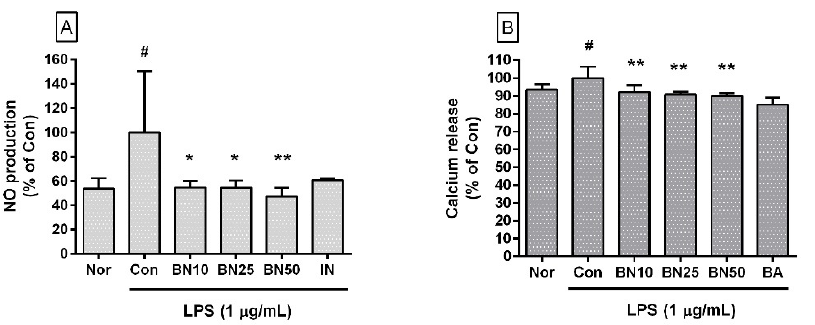
Figure 2. Effect of baicalin on nitric oxide (NO) production ( A ) and calcium release ( B ) in RAW 264.7 cells. Values are the mean ± SD of three independent experiments. Nor, normal group incubated with media only; Con, control group treated with 1 µ g/mL of lipopolysaccharide (LPS) only; BN10, BN25, and BN50 indicate 10, 25, and 50 µ M of baicalin, respectively; IN, indomethacin (0.5 µ M); BA, baicalein (25 µ M). # p < 0.5 vs. Nor; * p < 0.05 vs. Con; ** p < 0.01 vs. Con.